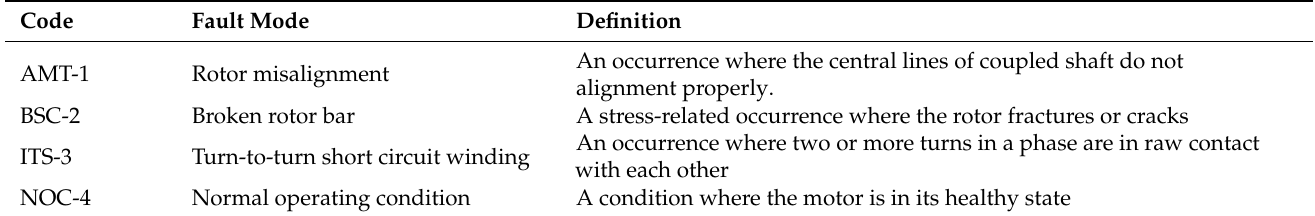
Table 3. Various operating conditions of the SCIM employed in the experimental